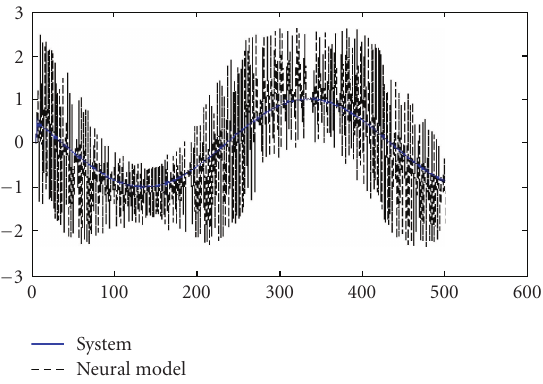
Figure 7: Evolution of the system output and the neural model output ( ε / ∈ stability